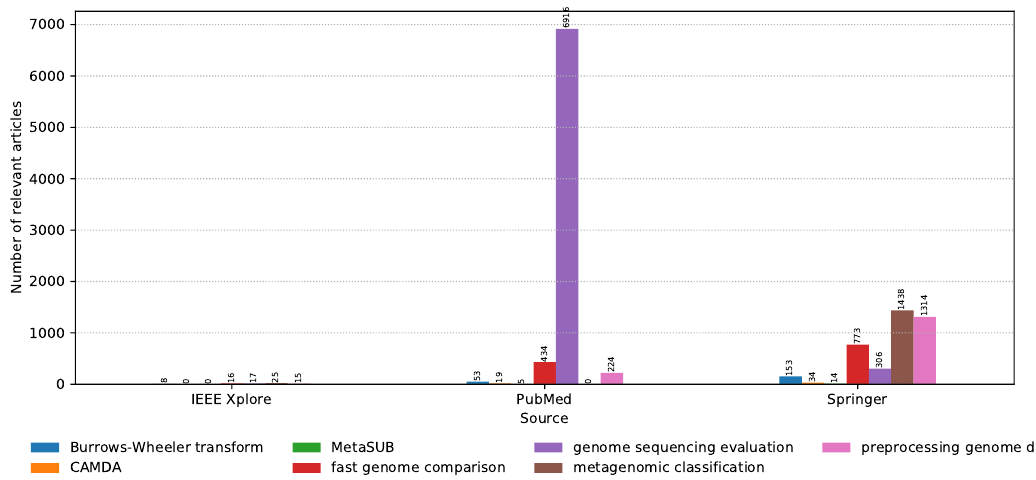
Figure 7. Distribution of the number of relevant articles for each keyword with respect to the digital